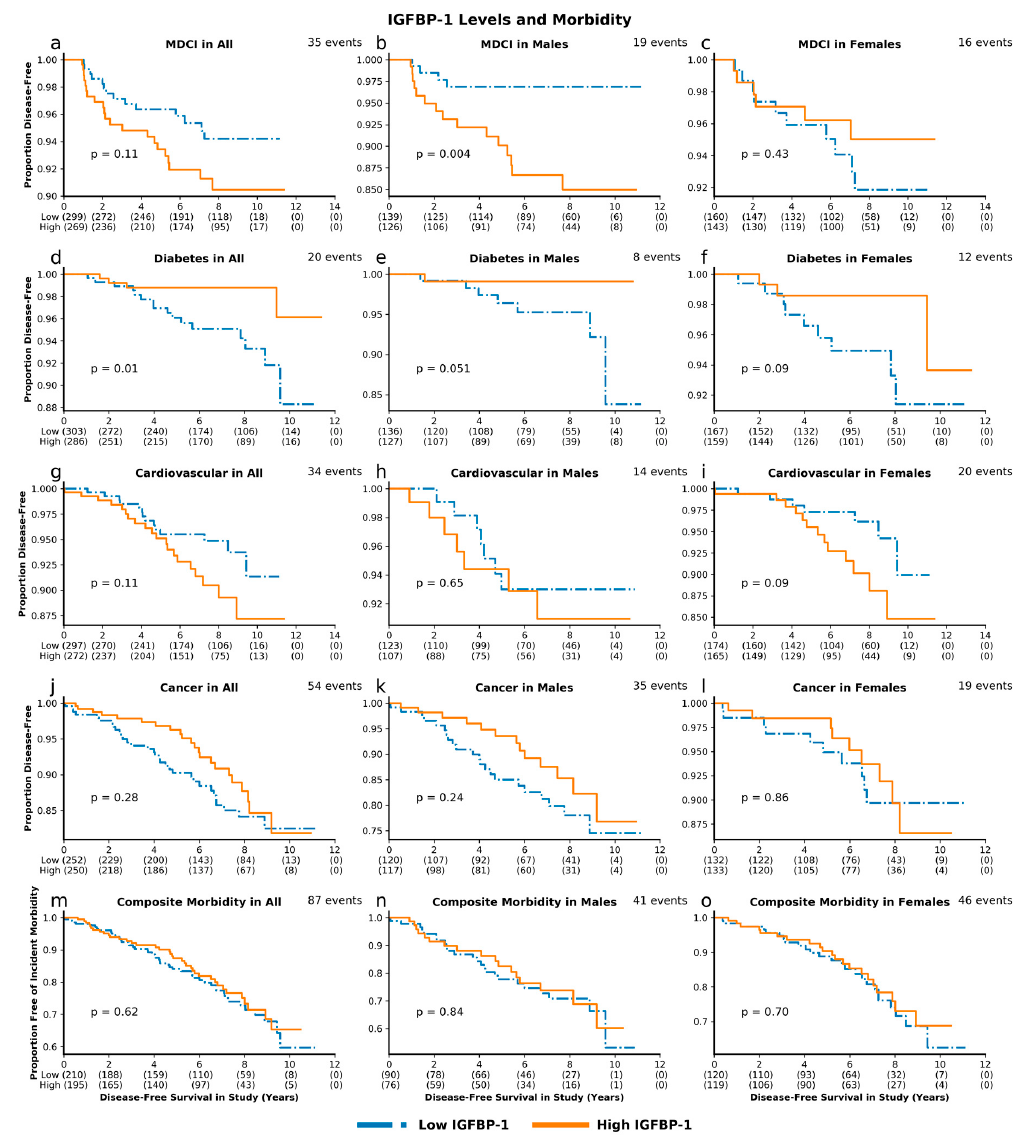
Figure 4. IGF-1 and morbidity hazard. Sex and age-adjusted morbidity hazards for all individuals in cohort ( a ), and age-adjusted morbidity hazards for males ( b ) and females ( c ) with high levels of IGF-1 as compared to individuals with low levels.